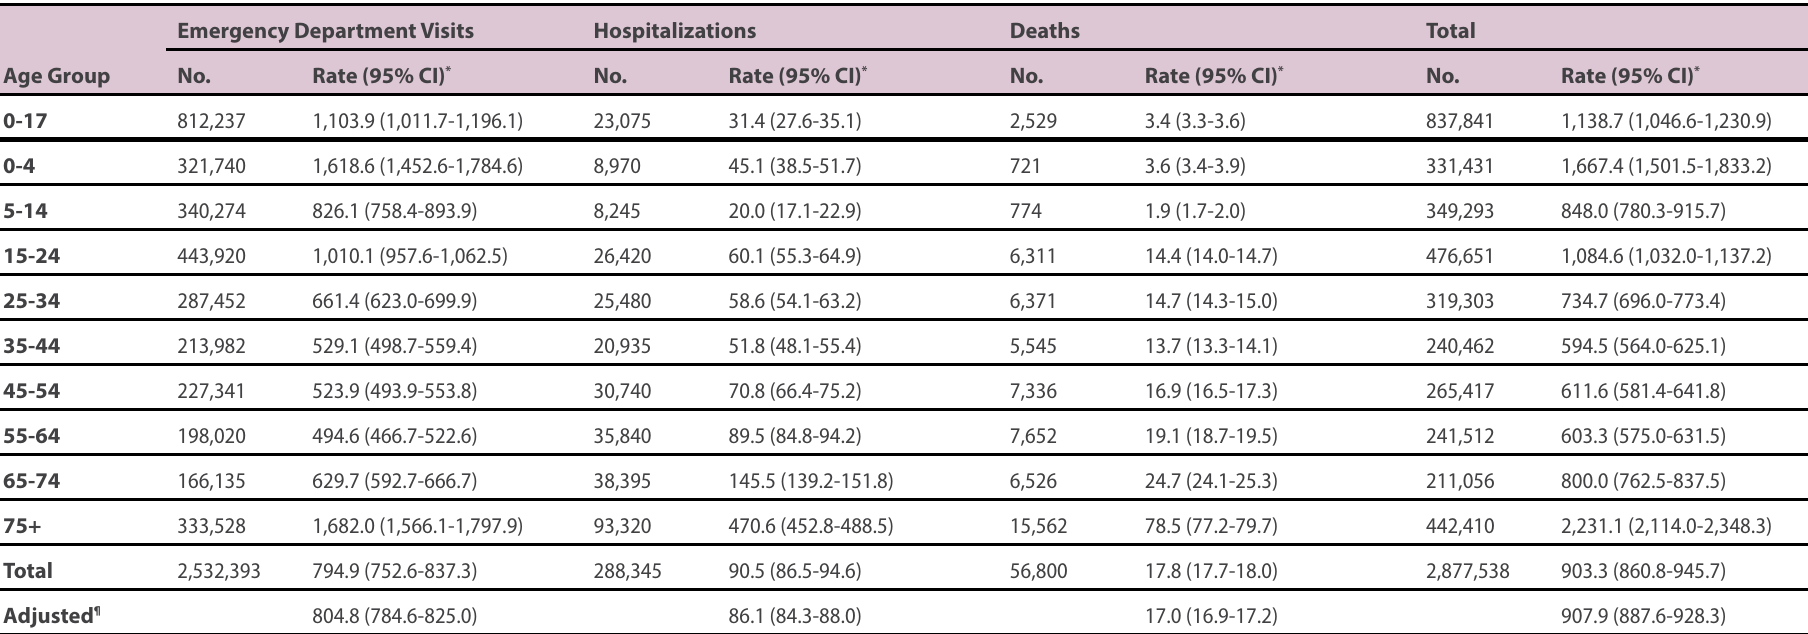
TABLE 1: ESTIMATED NUMBER AND RATE OF TRAUMATIC BRAIN INJURY–RELATED EMERGENCY DEPARTMENT VISITS, HOSPITALIZATIONS, AND DEATHS, BY AGE GROUP, 2014